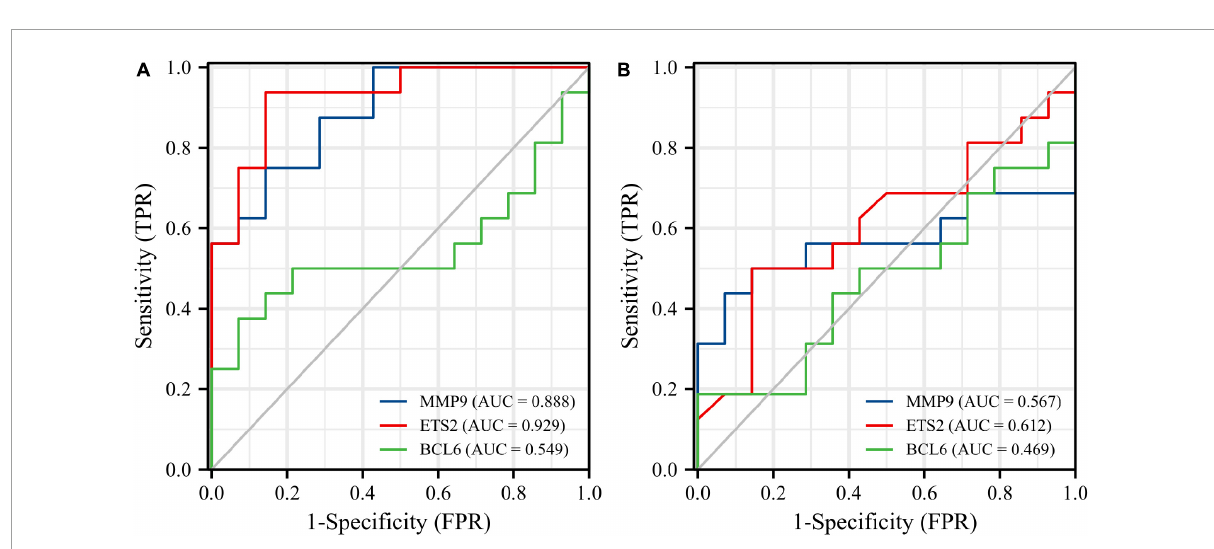
FIGURE14 Diagnostic values of three diagnostic genes in the GSE19322 dataset. ROC curves of MMP9 (blue), ETS2 (red), and BCL6 (green) at 1 day after AMI (A) . ROC curves of MMP9 (blue), ETS2 (red), and BCL6 (green) at 5 days after AMI (B) . ROC, receiver operating characteristic.